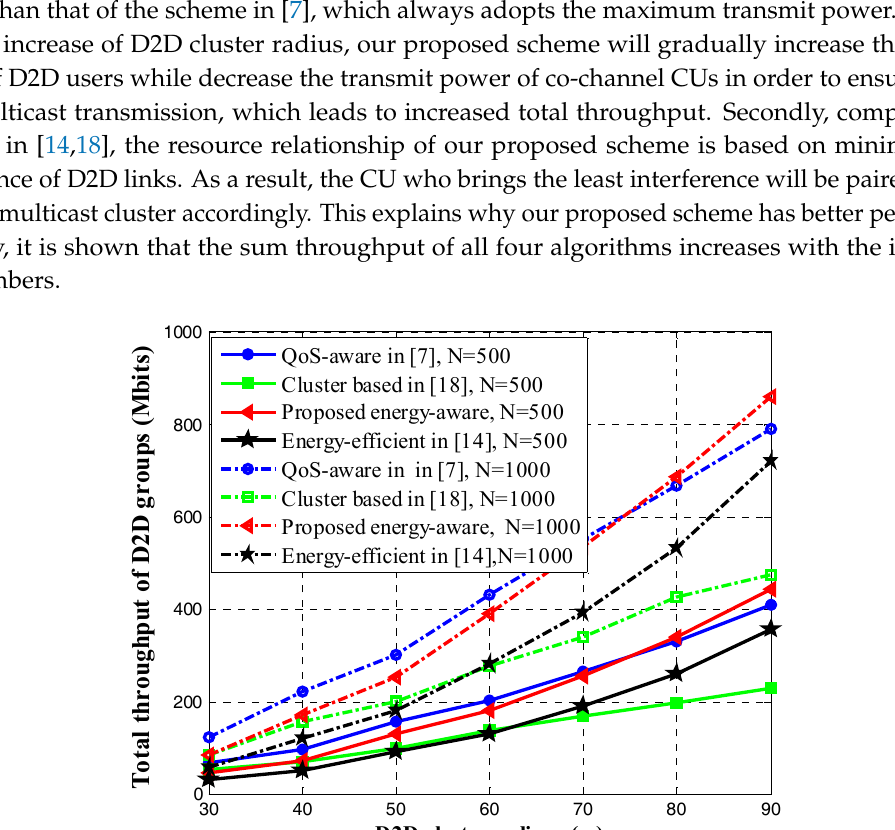
Figure 3. Total Throughput of D2D multicast clusters versus D2D cluster radius.